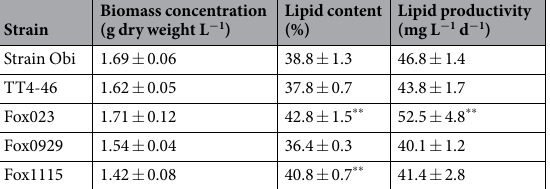
Cells of strains Obi, Fox023 and FDox037 were grown in either 1/3 strength A7 medium or A7 medium, and they were stained with Nile Red, which is strongly fluorescent in neutral lipids. The micrographs in Fig. 3 showed